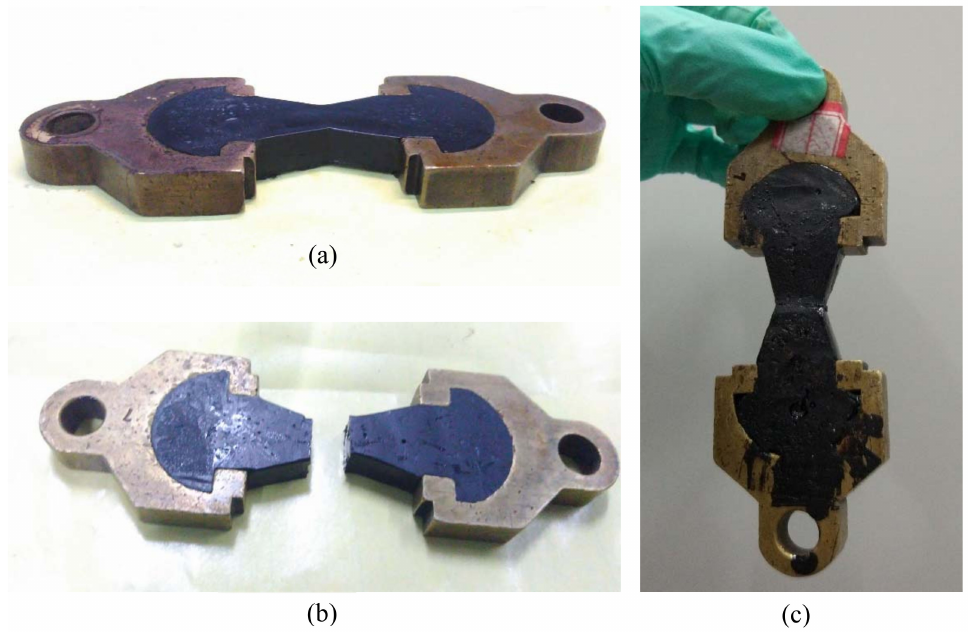
Figure 10. The process of tensile stress-recovery test: ( a ) ductility specimen at low temperature; ( b ) brittle fracture of specimen; ( c ) the two parts were connected again at low temperature.